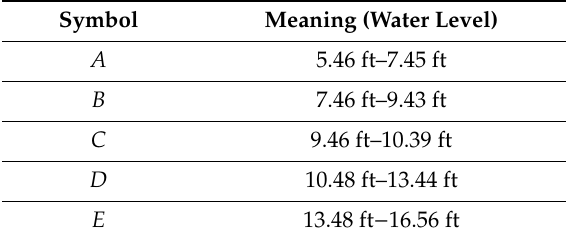
Table 1. The character sets and their meanings for the mean feature.